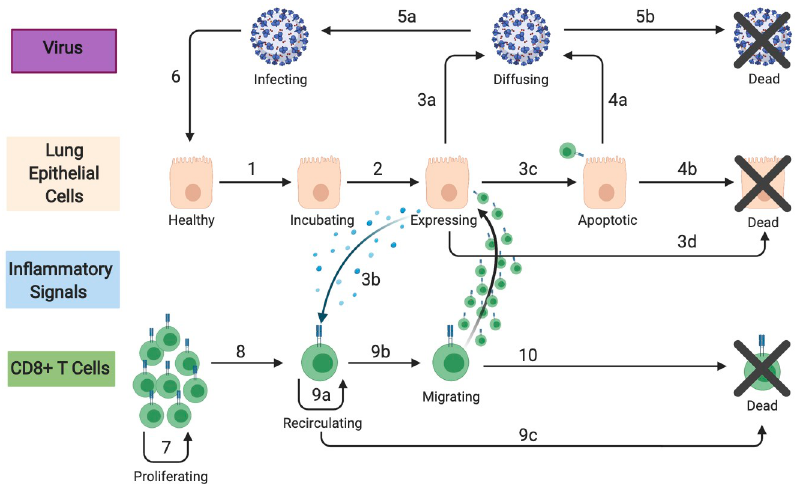
Fig 1. SIMCoV model components and their interactions. Epithelial and T cells are represented as agents; virions and inflammatory signals are represented as concentrations. Numbered transitions are described in Materials and